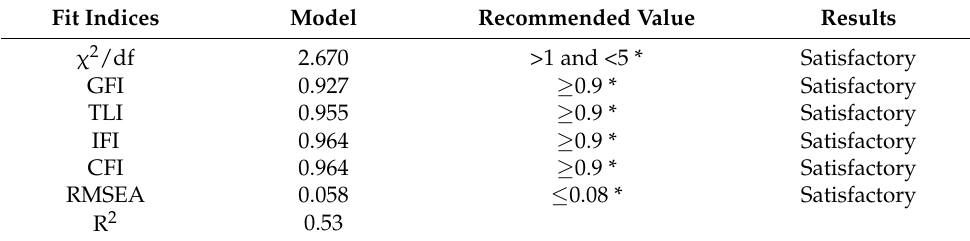
Table 7. Summary of fit indices from confirmatory factor